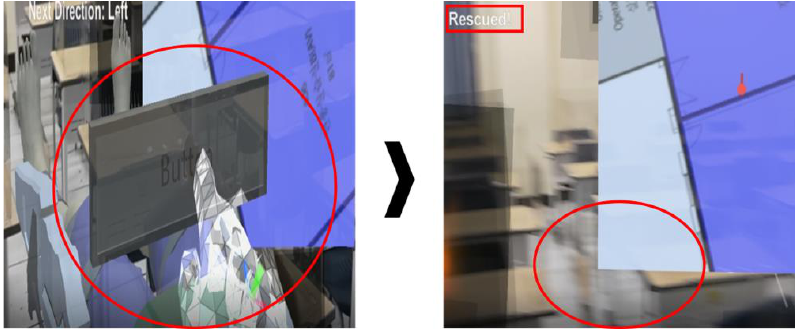
Figure 13. Process of rescuing disaster victims.